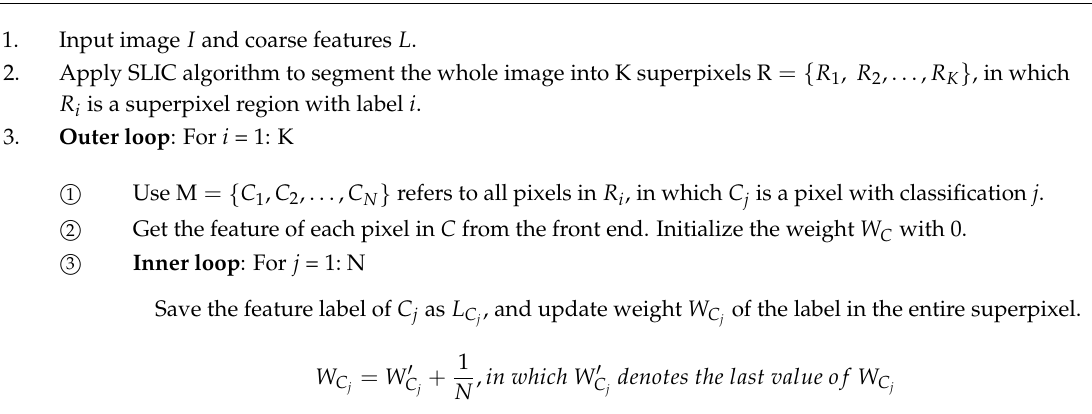
Figure 3. Boundary optimization using superpixels. Algorithm 1. The algorithm of boundary optimization.